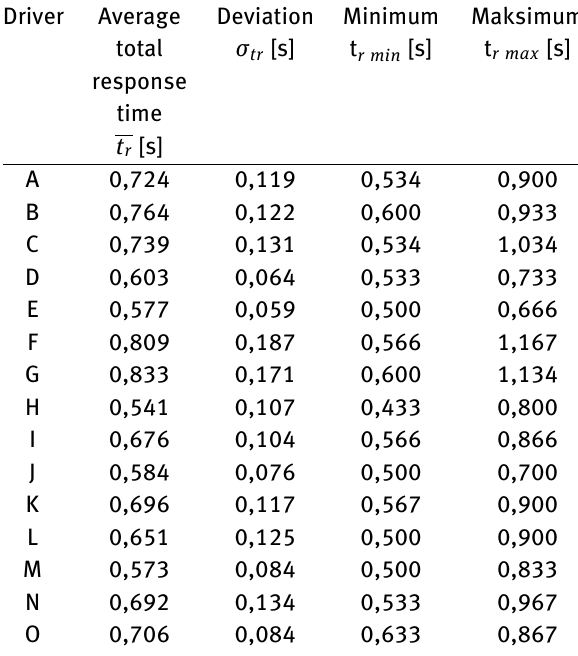
Table 21: Summary of test results.